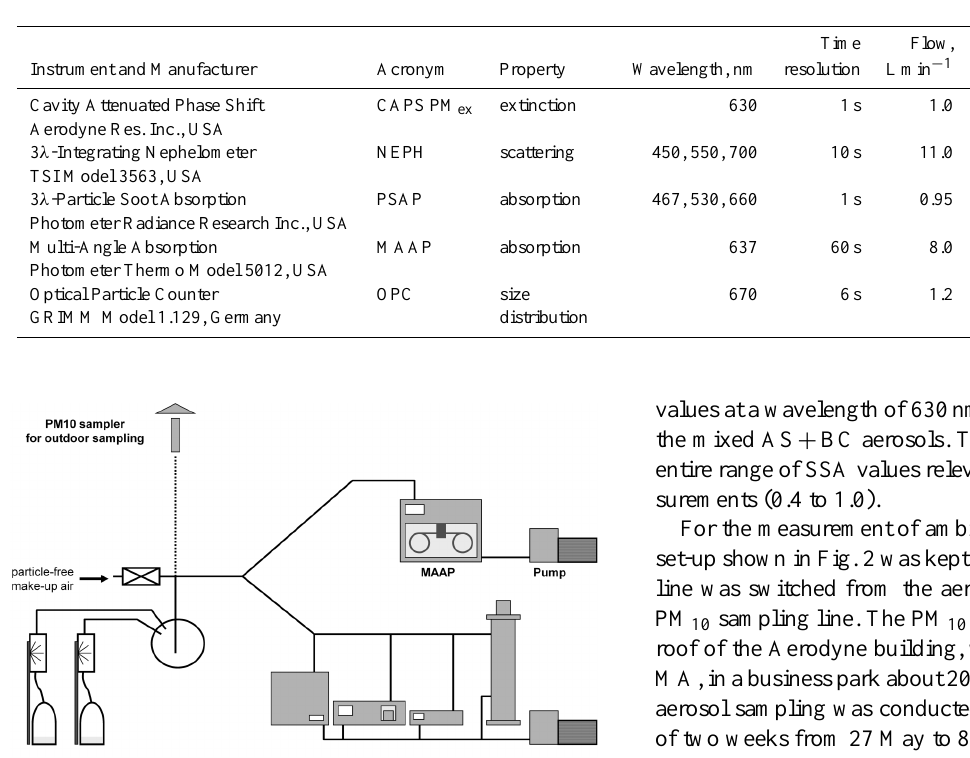
Table 1. Instruments used during the evaluation experiments.